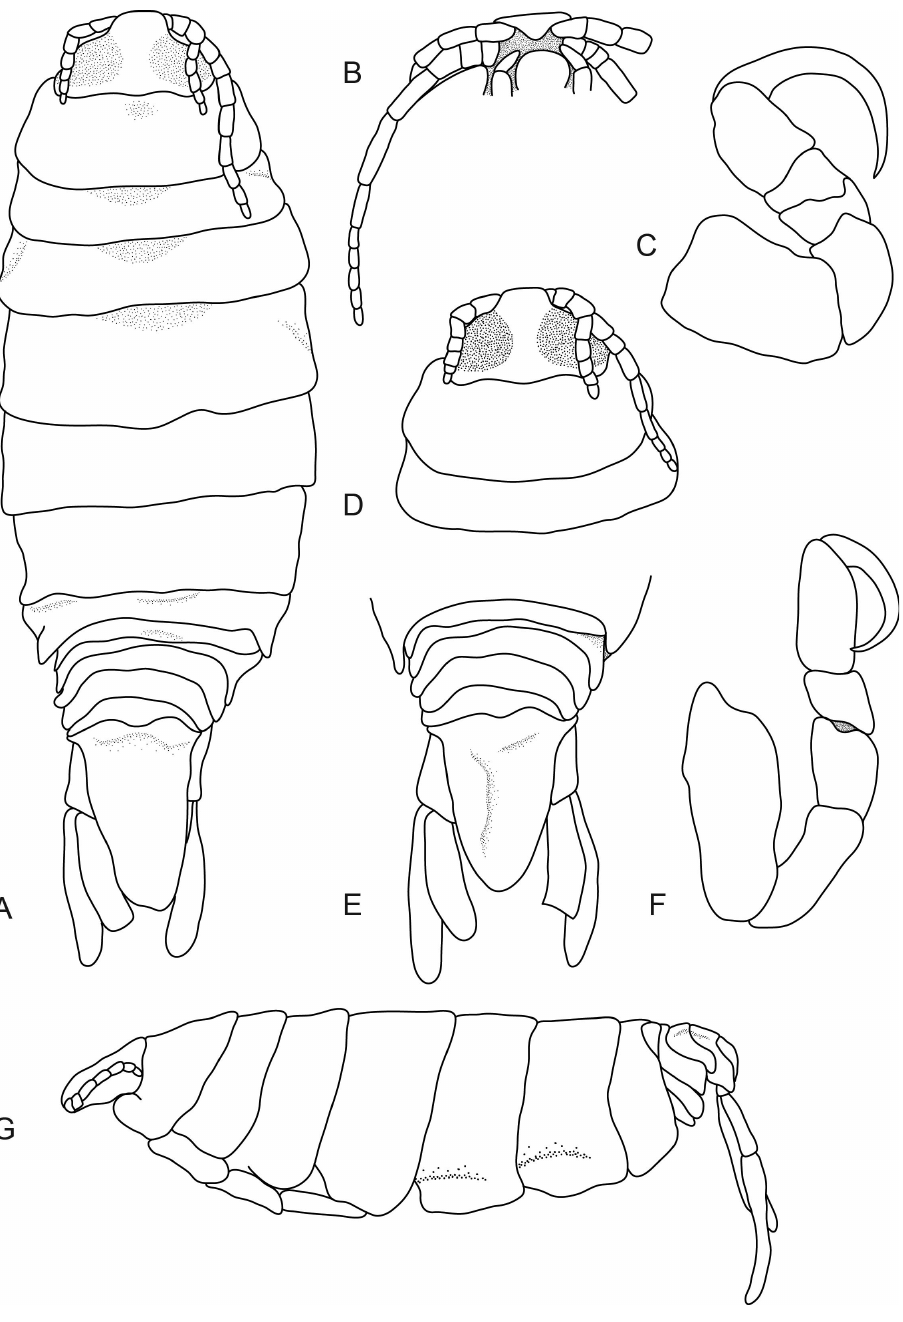
Figure 3. Pleopodias vigilans Richardson, 1911 (MNHN-IU-2014-12188), female holotype (28 mm). A dorsal view B ventral view of cephalon C pereopod 1 D dorsal view of pereonite 1, pereonite 2 and cephalon E dorsal view of pleon and pleotelson F pereopod 7 G lateral